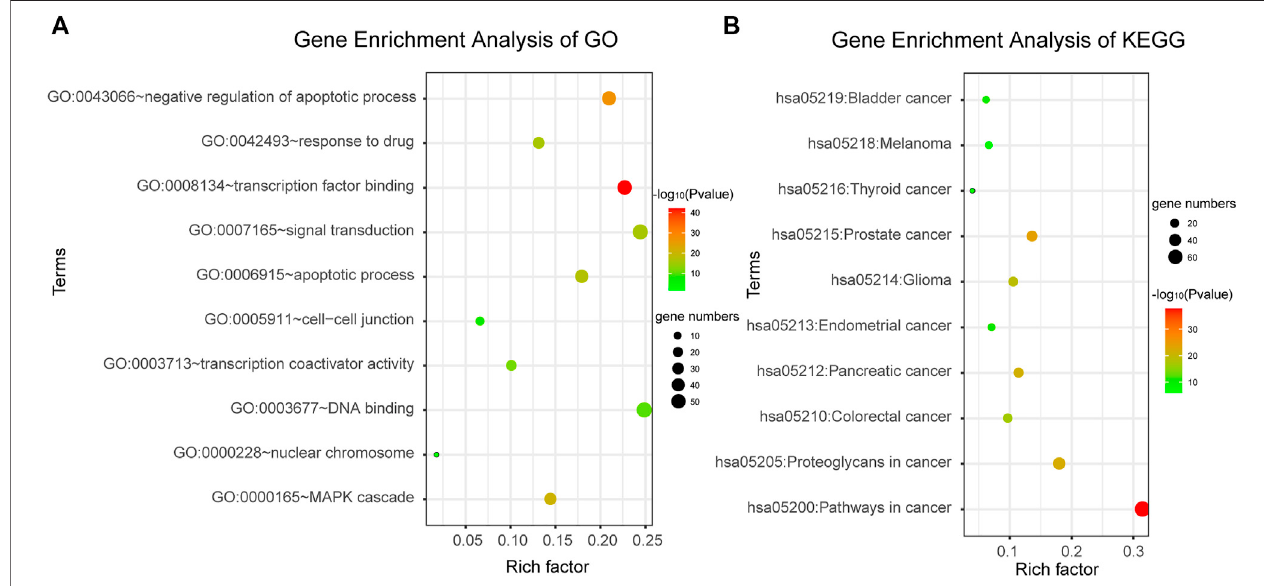
FIGURE 3 | Gene enrichment analysis. (A) Gene enrichment analysis of Gene Ontology. (B) Gene enrichment analysis of KEGG.